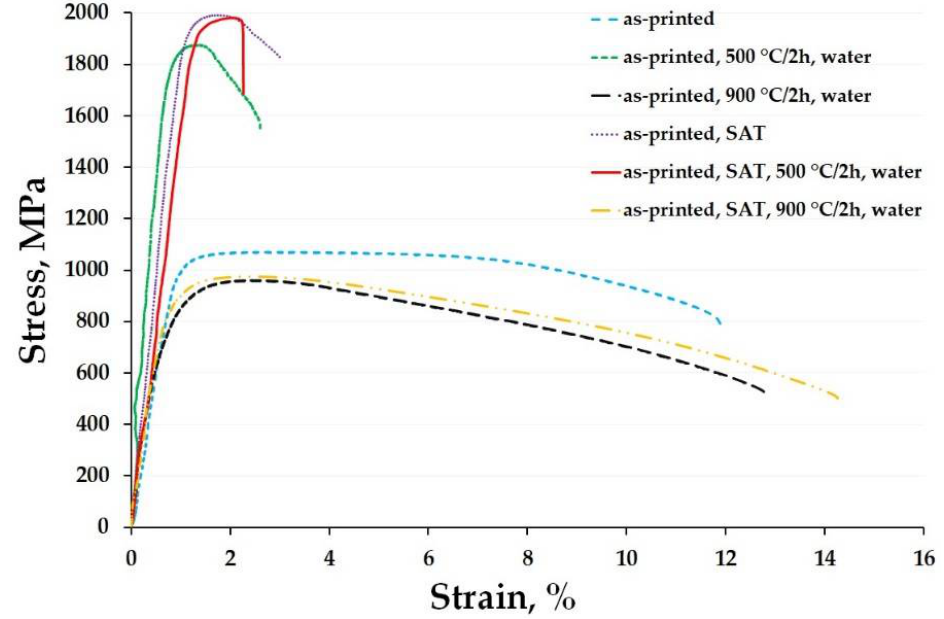
Figure 3. Tensile tests of the 1.2709 maraging steel under a variety of conditions including the initial state (as-printed, and as-printed, SAT) and those which were annealed at 500 °C and 900 °C for 2 h and water quenched.